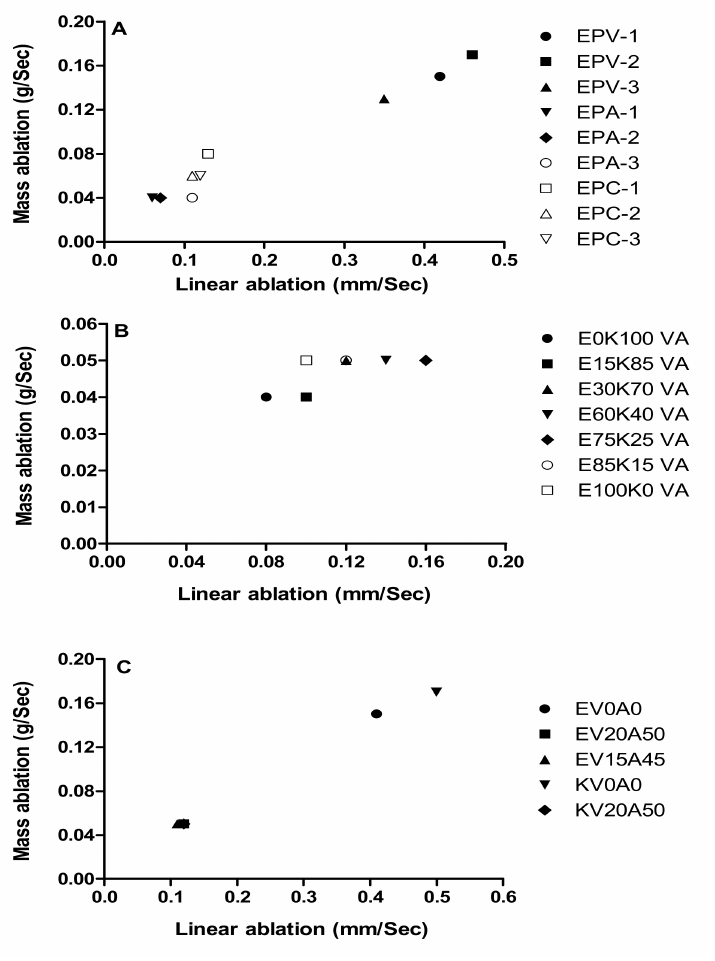
Figure 7. Plots of linear and mass ablation values of ( A ) phase-1, ( B ) phase-2, and ( C ) phase-3